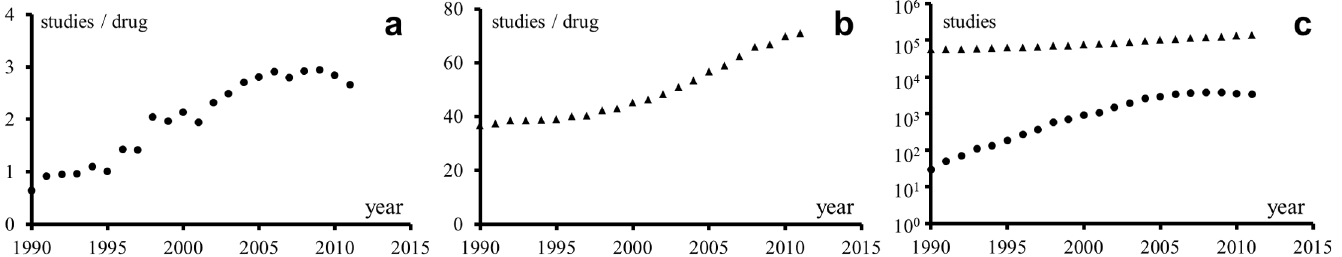
Fig 1. Average number of studies per drug per year. (a) Clinical . (b) Literature . (c) Number of studies in each dataset per year: Literature (triangles), Clinical